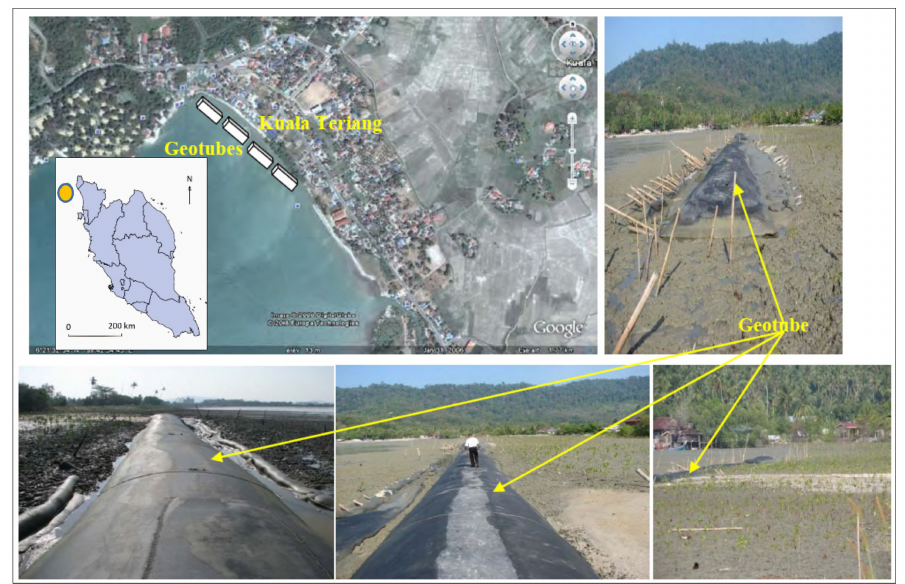
Figure 16. Geotube protection for mangrove reforestation in Kuala Teriang [102]. ‘Reprinted from Mangrove Reforestation in Kuala Teriang area, Langkawi, 2008; open access publication by SEAFDEC